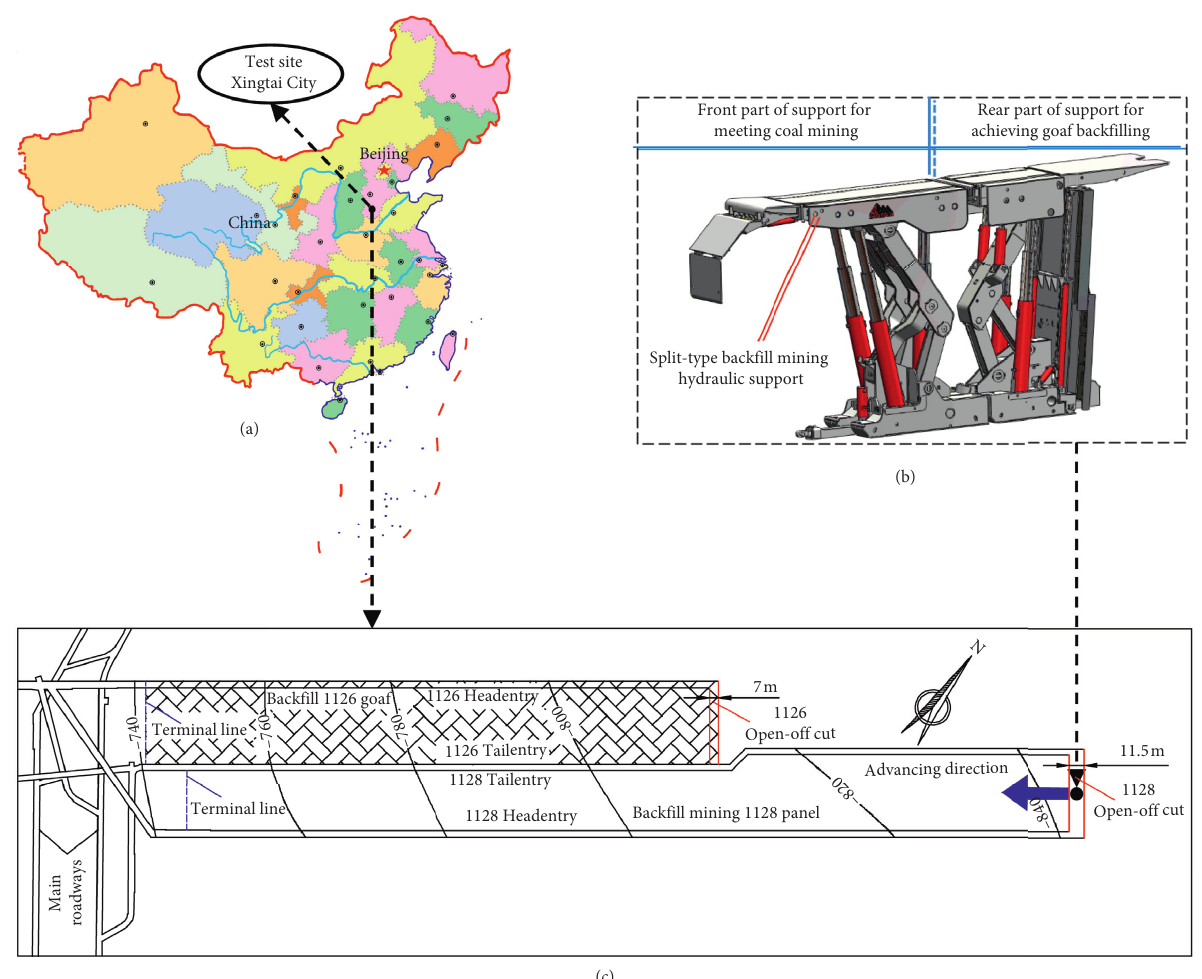
Figure 1: Mine location and panel layout of the test site. (a) Mine location. (b) Structure diagram of split-type backfill mining hydraulic support. (c) Schematic plan of roadways and